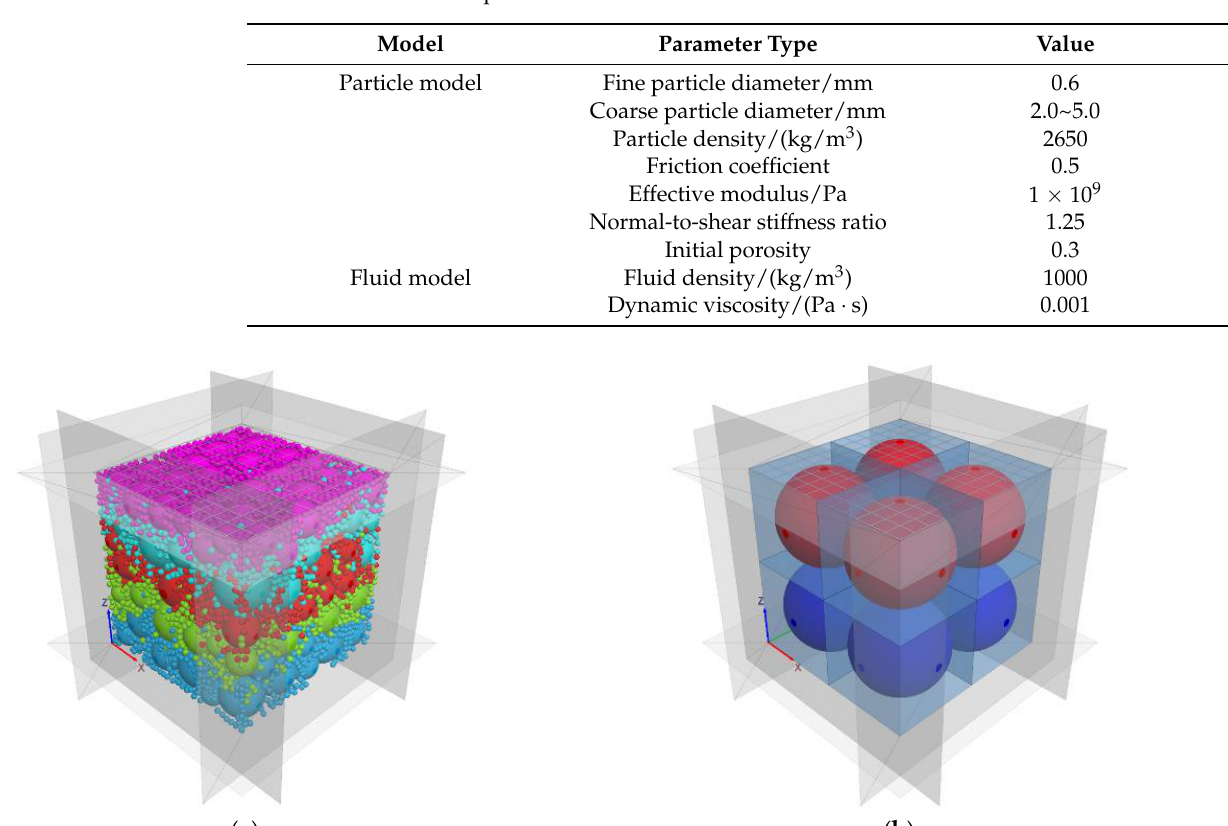
Figure 2. Particle gradation used in the simulation. Table 1. Table of model parameters. Table 1. Table of model parameters.